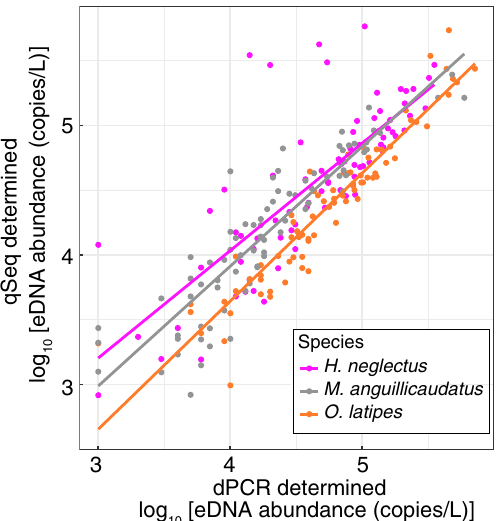
Figure 5. Correlation between eDNA copy number as quantified by digital PCR (dPCR) and quantitative sequencing (qSeq). Lines indicate regressions for each species, where pink is H. neglectus : [log(qSeq) = 1.052(dPCR) − 0.043, R 2 = 0.643, P < 0.0001, Gaussian Type II regression]; grey is M. anguillicaudatus : [log(qSeq) = 1.114(dPCR) − 0.112, R 2 = 0.859, P < 0.0001]; and orange is O. latipes : [log(qSeq) = 1.074(dPCR) − 0.058, R 2 = 0.786, P <